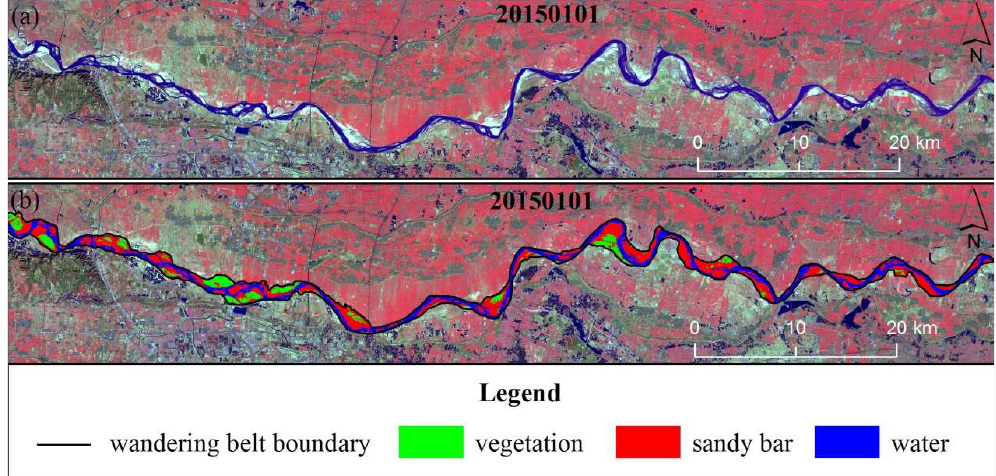
Figure 5. Images of the study reach derived from the original Landsat image taken in January 2015: ( a ) image with a false color composite and ( b ) image overlaid with the units of vegetation (both grass and winter wheat), sandy area, water body, and the wandering belt boundary in the study area.